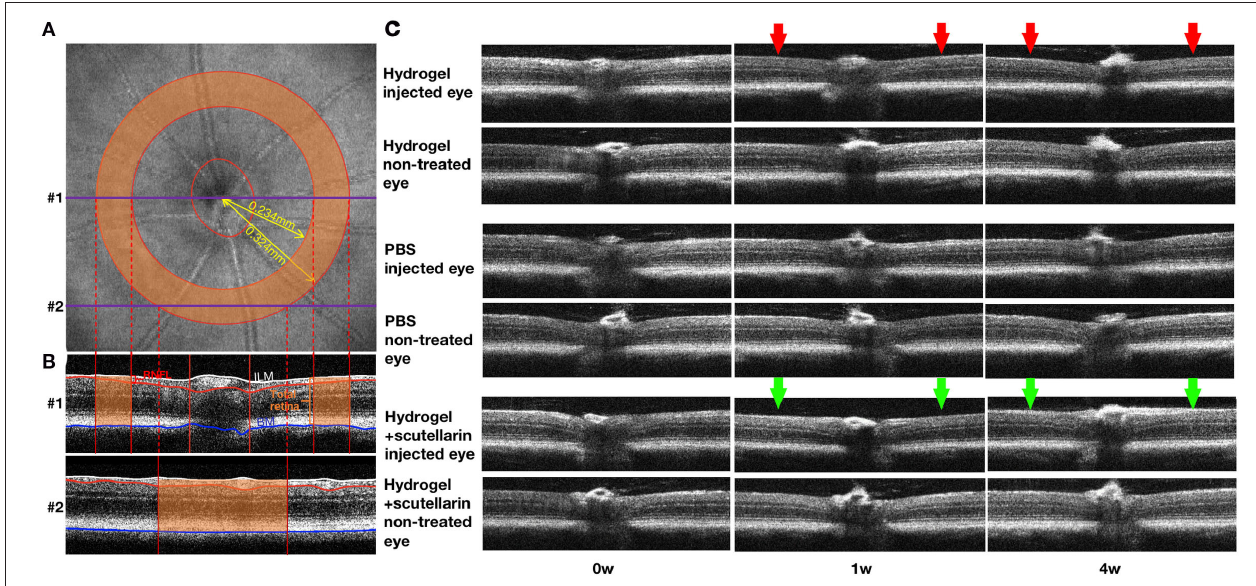
FIGURE 2 | Optical coherence tomography of the mouse retina over time. (A) en face image showing the optic nerve head (ONH) and a sampling band (orange) of 0.234 to 0.324mm radius centered on the ONH for measuring retinal nerve fiber layer (RNFL) thickness and total retinal thickness (TRT). (B) Two representative cross-sectional retinal B-scan images corresponding to the linear scans #1 (through the optic nerve) and #2 (around the optic nerve) in (A) . The RNFL (red bracket), inner limiting membrane (ILM; white line), and Bruch’s membrane (BM; blue line) were outlined using a custom-written automated segmentation algorithm. RNFL thickness was defined as the distance between white and red lines, and TRT was defined as the distance between white and blue lines. Only the thicknesses within the orange sampling band were measured and averaged for each eye for further analyses. (C) Cross-sectional retinal images from both injected and contralateral, non-treated eyes of a representative mouse in each of the 3 groups at 0 week (0w; pre-injection), 1 week (1w) and 4 weeks (4w) after unilateral intracameral injection. Note the clear images indicating the transparency of the ocular media comprising the hydrogel. Note also the apparent inner retinal thinning in the injected eye of the hydrogel-only group (Group 1; red arrows), and less apparent retinal thinning in the hydrogel + scutellarin group (Group 3; green arrows). No obvious retinal change was observed in the injected eye of the PBS group and in the non-treated eyes of all three